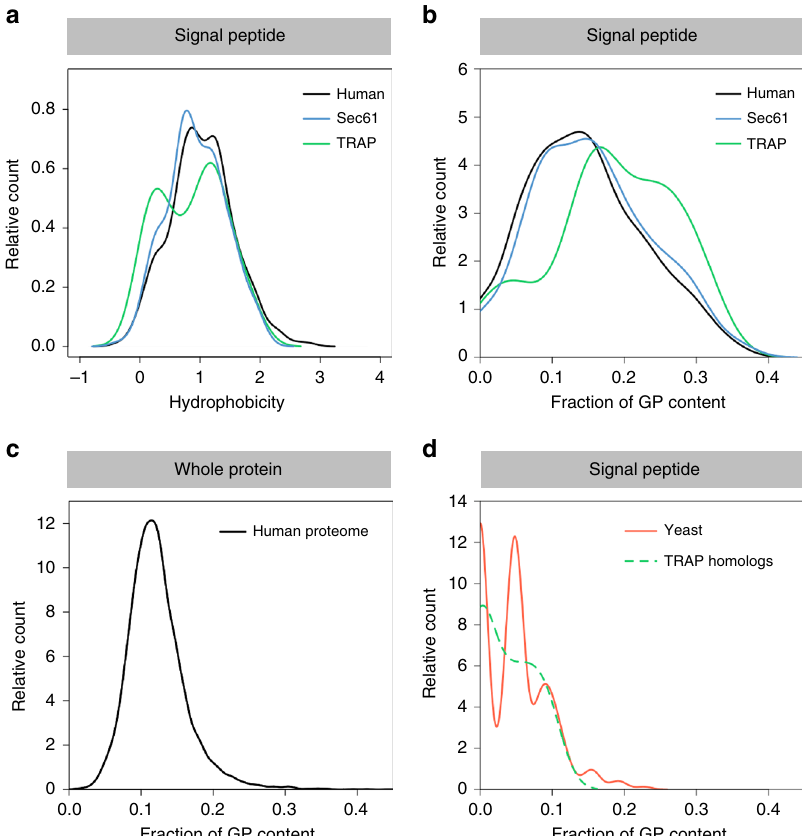
Fig. 5 Physicochemical properties of TRAP clients with SP. The color coding follows Fig. 1. We used custom scripts to compute the hydrophobicity score ( a ) and glycine/proline (GP) content ( b ) of SP sequences. Hydrophobicity score was calculated as the averaged hydrophobicity of its amino acids according to the well-known Kyte-Doolittle propensity scale. GP content was calculated as the total fraction of glycine and proline in the respective sequence. Additional plots are shown in Supplementary Fig. 4a, b. We also used custom scripts to extract protein annotations for all human proteins ( c ) and yeast SP ( d ) from UniProtKB entries. TRAP homologs refer to yeast orthologs of eight TRAP dependent human proteins as indicated in Table 1. d Notably, the fi rst peak refers to no GP per yeast SP, the second to one GP, the third to two GPs, and so on. This oscillatory appearance appears to be obscured by the higher variation